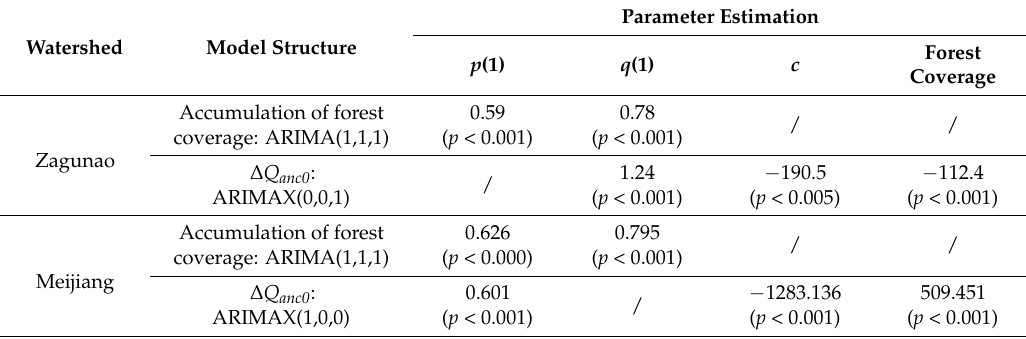
Table 6. ARIMAX models for accumulation of forest coverage and ∆ Q anc0 .